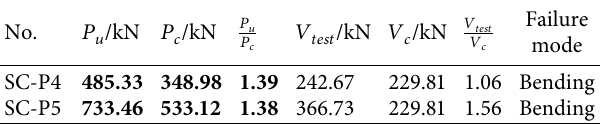
Figure 26: Theoretical calculation diagram. Table 5: Comparison between the test and theoretical results of the out-of-plane shear capacity of steel plate-concrete slabs. Table 6: Comparison between the test and theoretical results of the out-of-plane bending capacity of steel plate-concrete No.